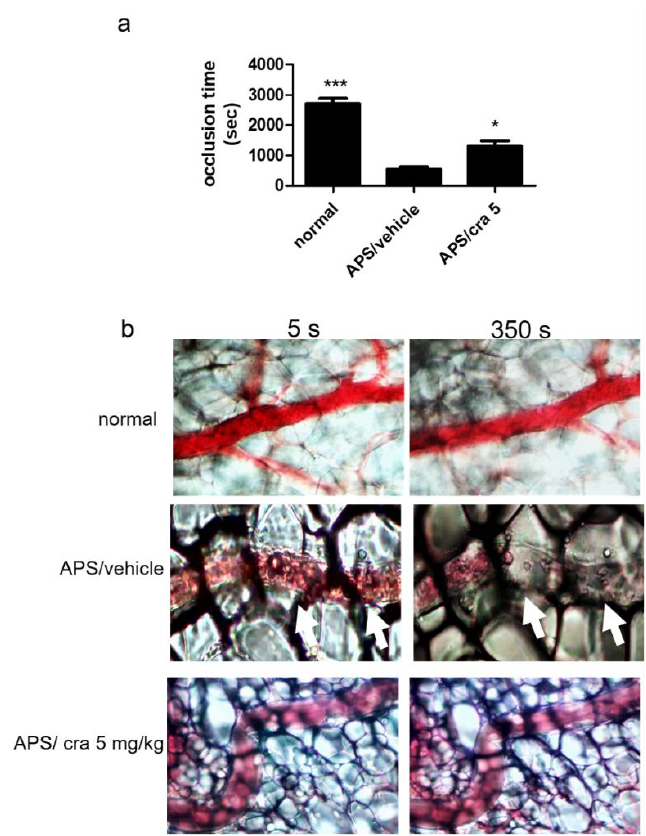
Figure 7. Effects of crassolide on thrombosis formation in the mesenteric venules of mice. Mice were given vehicle control (10% DMSO and 90% glyceryl trioctanoate) or crassolide (5 mg/kg) and the mesenteric venules were irradiated to induce microthrombus. ( a ) The occlusion time, ( b ) Microscopic images (400× magnification). Data are presented as mean ± SEM of 5 mice from one of three independent experiments. * p < 0.05, *** p < 0.001, versus vehicle-treated APS mice group, tested by one-way ANOVA followed by Tukey’s multiple comparison test.